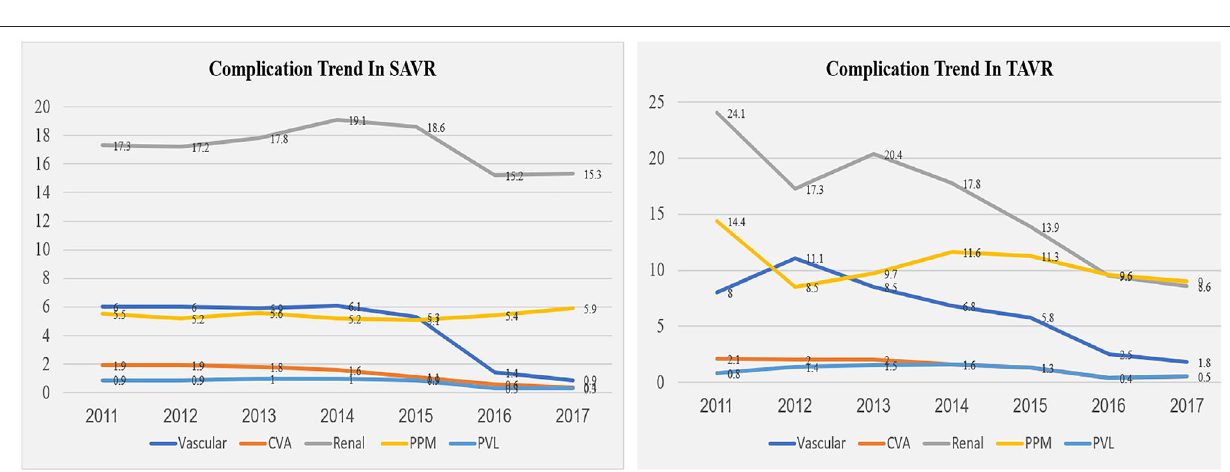
cerebrovascular disease, renal disease, congestive heart failure, or Deyo-CCI score above 2 are at higher risk for mortality in the SAVR procedure compared with the TAVR